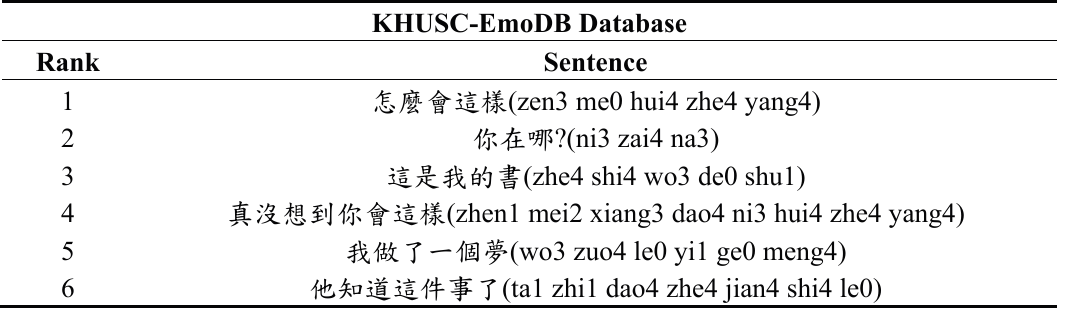
Table 5. The emotional sentences for KHUSC-EmoDB.